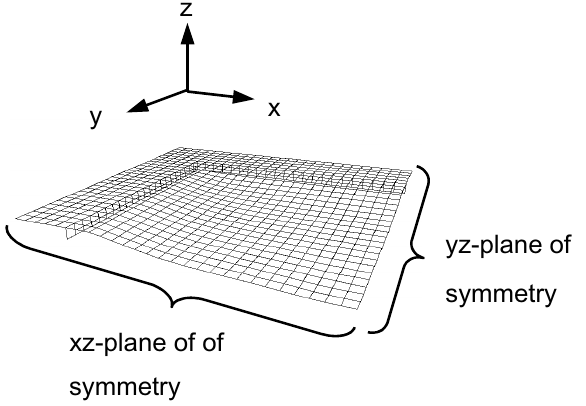
Fig. 2. The quarter symmetry model of the plate surface showing the boundary conditions for the symmetry planes. The nodes coincident with the symmetry planes indicated in diagram are restricted to motions in the xz-plane, the yz-plane and z-axis direction,